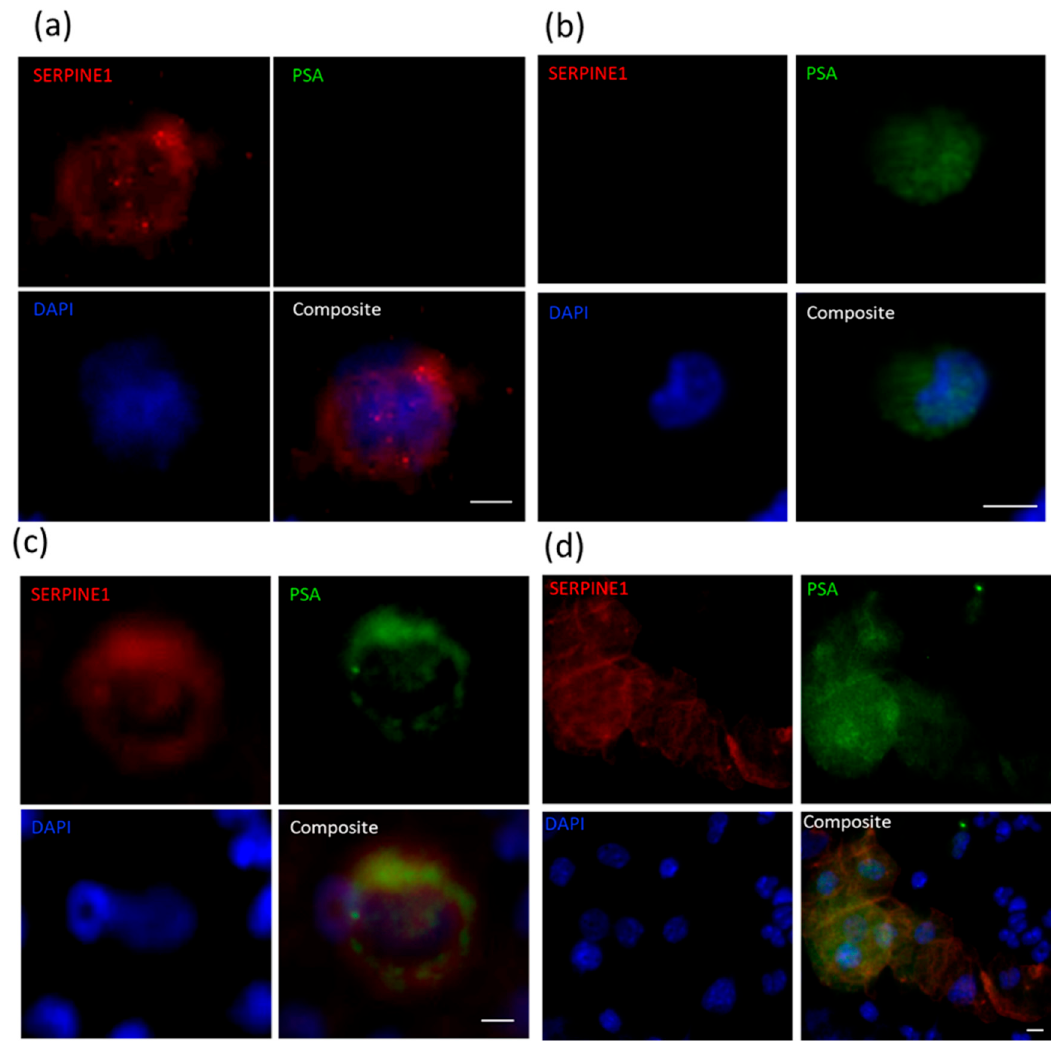
Figure 8. Immunofluorescent staining for SERPINE1 and PSA in PDX-derived CTCs. Representative images using PDX mouse blood of CTCs staining positive for ( a ) SERPINE1 only (LuCaP96), ( b ) PSA only (LuCaP70) or ( c ) both SERPINE1 and PSA (LuCaP96), and ( d ) CTC cluster composed of both SERPINE1 + PSA − cells and SERPINE + PSA + cells surrounded by murine PBMCs (LuCaP70). Scale bar denotes 5 µ